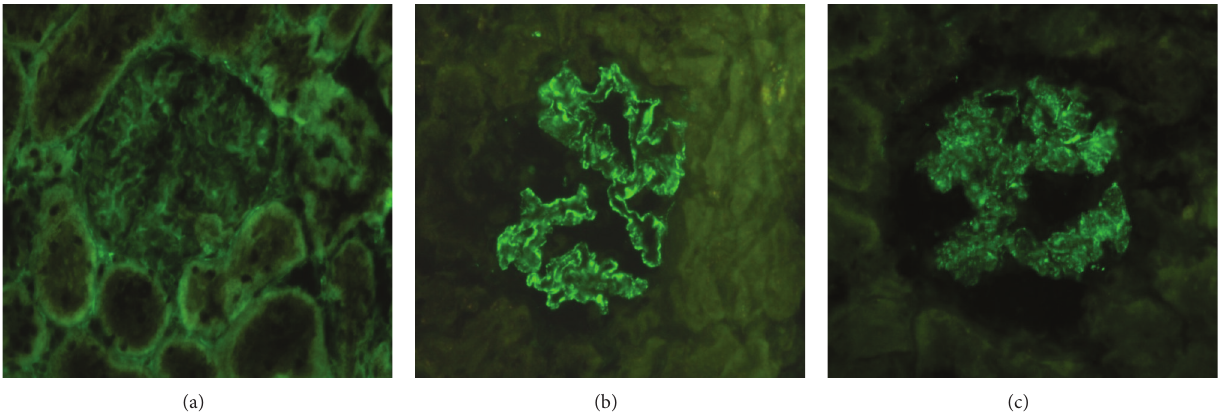
Figure 3: Immunofluorescence staining with anti-Rat IgG. (a) Healthy controls showed absence of staining. Original magnification × 400. (b) Passive Heymann Nephritis; glomeruli showed intense (3+) granular and irregular fluorescence along the capillary walls ( × 400). (c) Passive Heymann Nephritis after rapamycin administration; staining was significantly attenuated (1+ to 2+) in almost all glomeruli ( × 400).